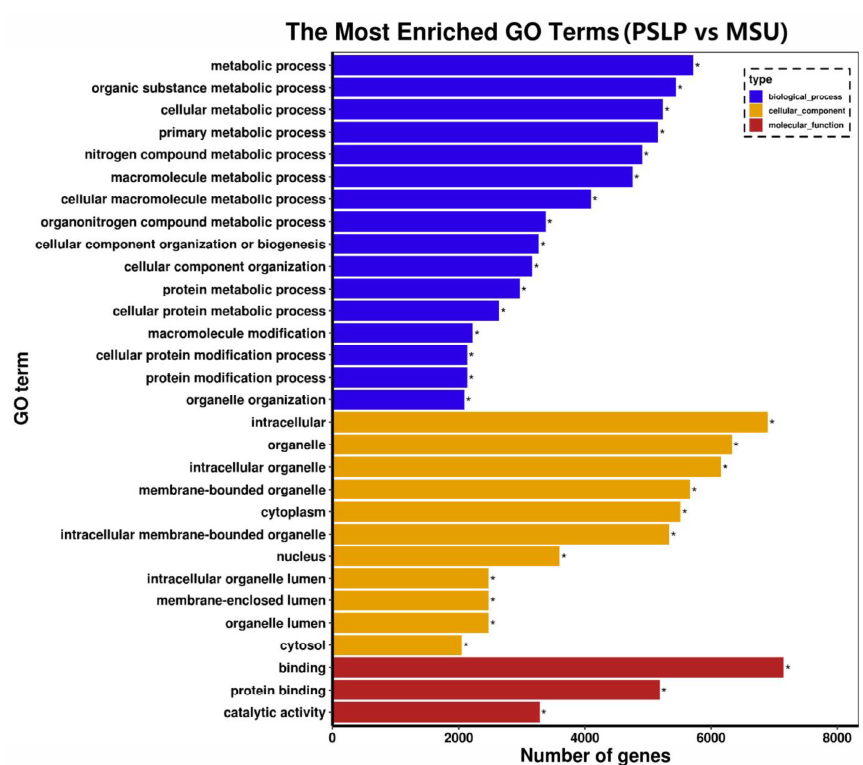
Figure 8. The GO enrichment analysis of the DEGs. The vertical coordinate is the enriched GO term, and the horizontal coordinate is the number of DEGs in the term. Different colors are used to distinguish between biological processes, cellular components, and molecular functions, with “*” indicating the significantly enriched GO terms.